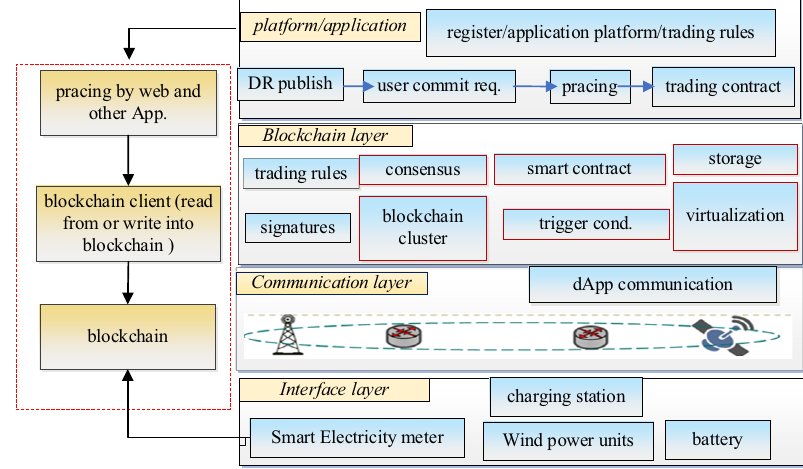
Fig. 1. Architecture of the blockchain-based trading system, four